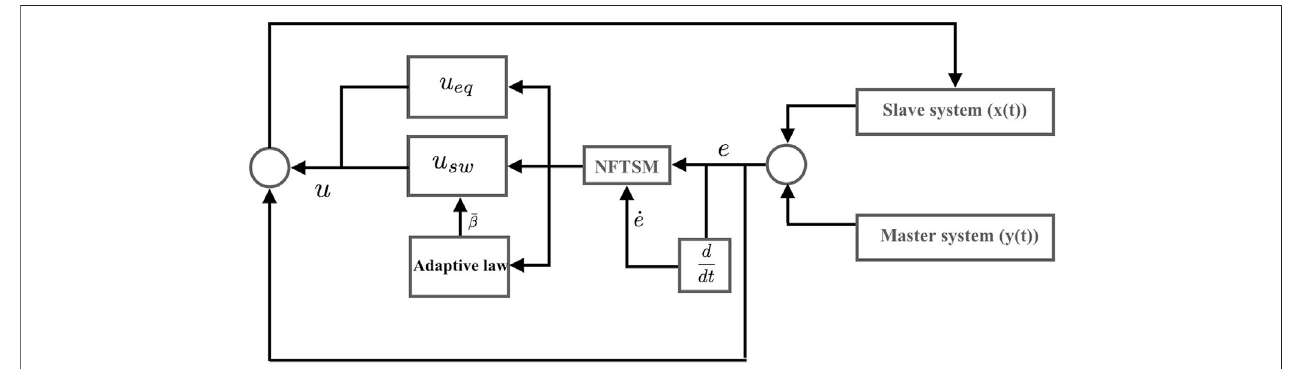
FIGURE 1 | The block diagram of chaos synchronization using ANFTSM